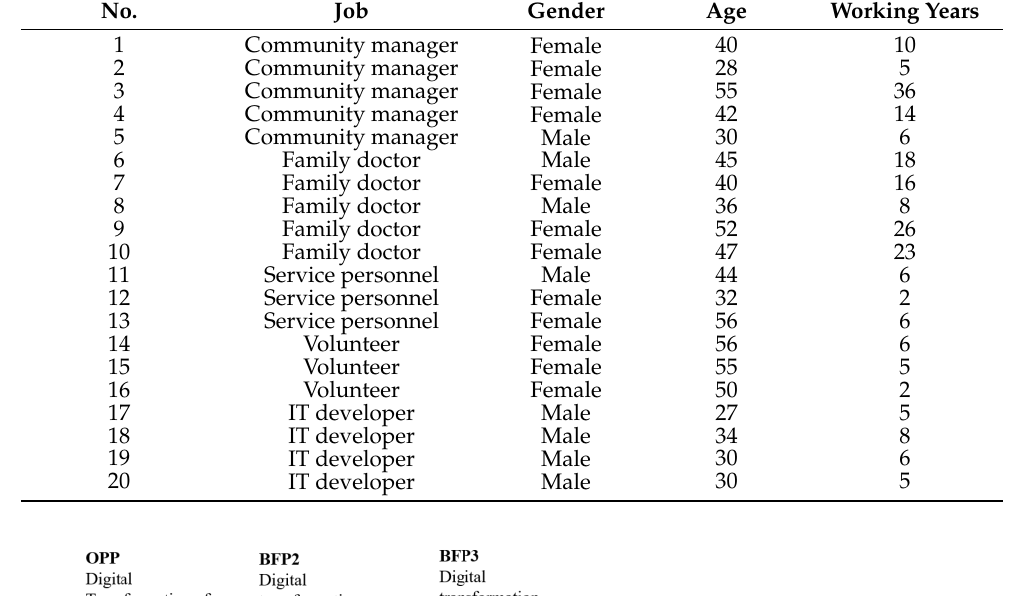
Table 5. Supply-side interviewer information.